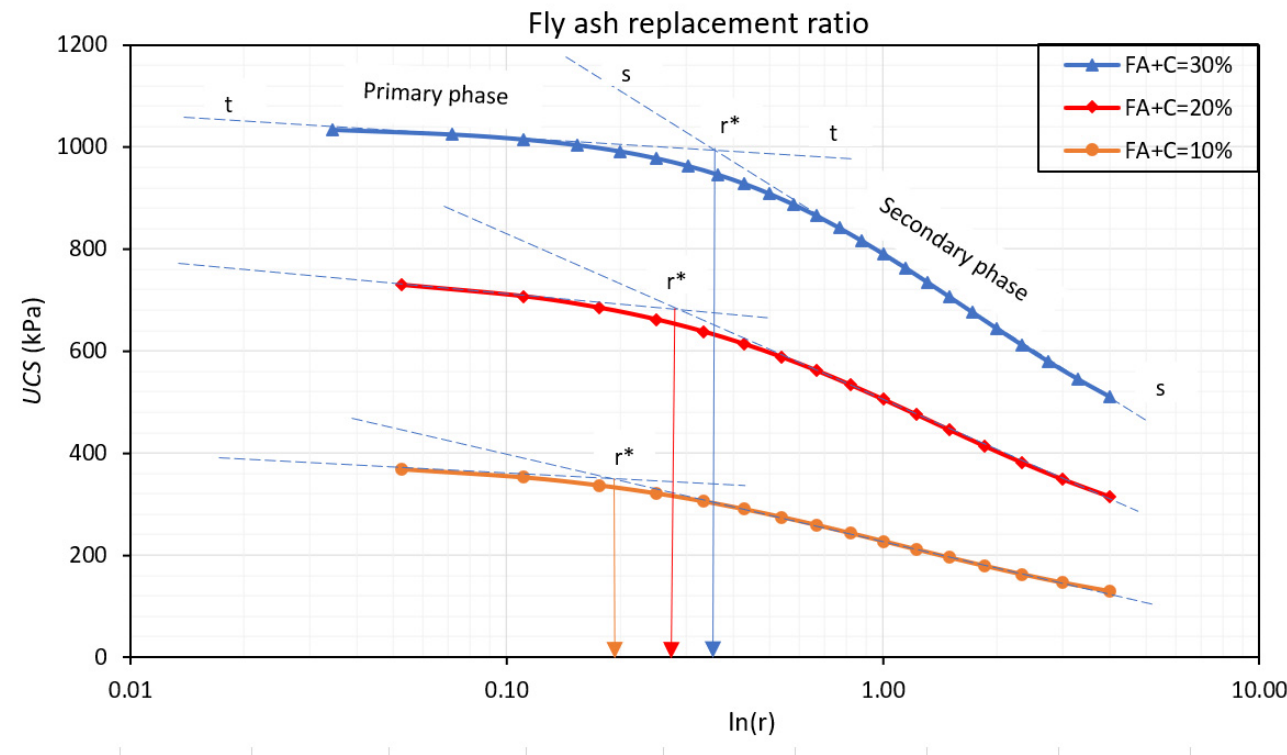
Figure 5. Effect of fly ash replacement ratio.